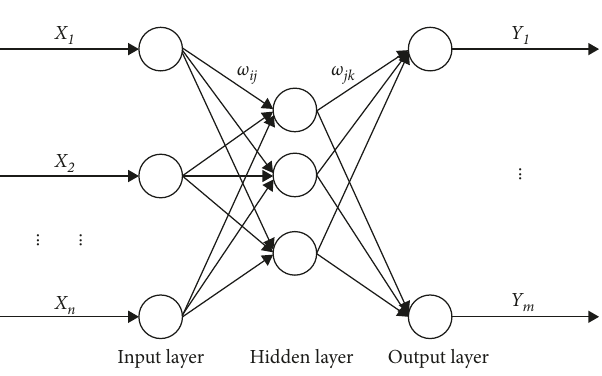
Figure 1: BP neural network topology.